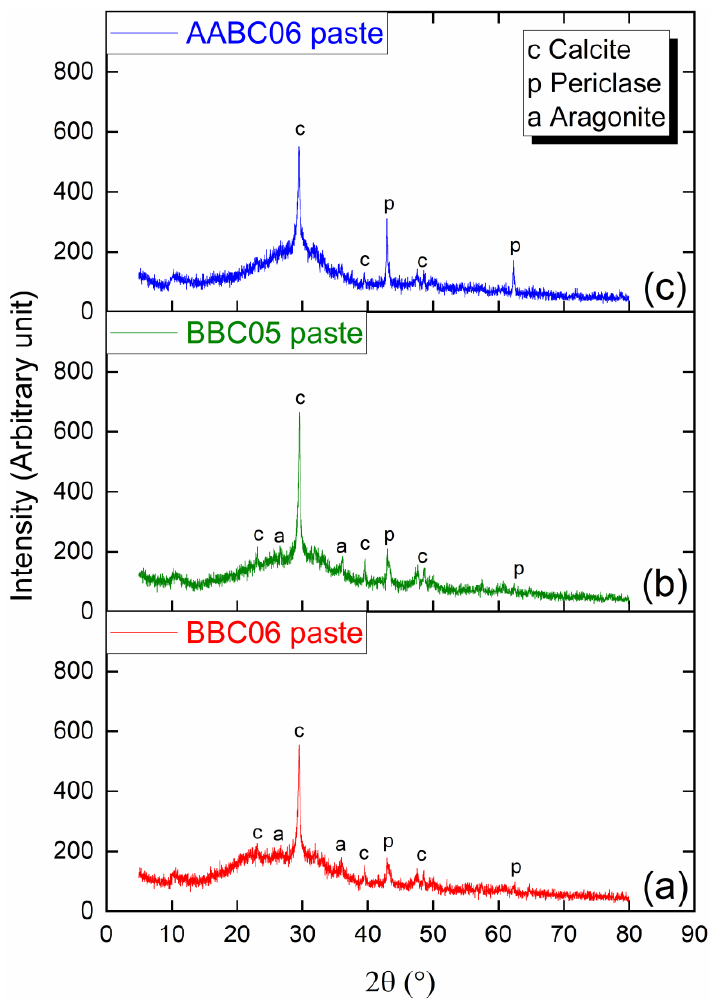
Figure 11. XRD of ( a ) BBC06 paste, ( b ) BBC05 paste, and ( c ) AABC06 Figure 11. XRD of (a) BBC06 paste, (b) BBC05 paste, and (c) AABC06 paste.